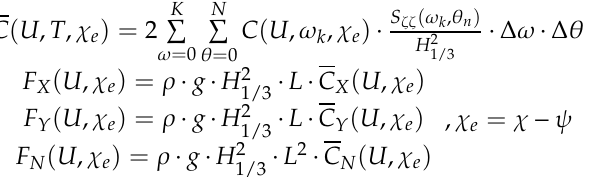
Figure 18. Added mass (A 22 ).